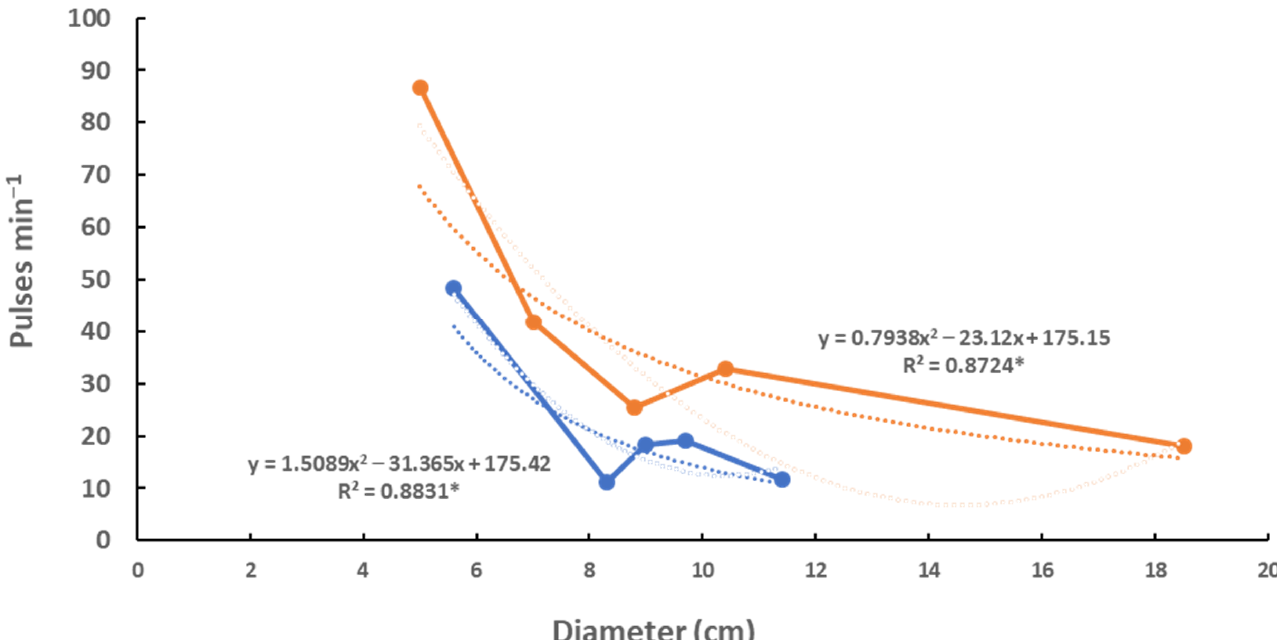
Figure 8. Pulse rates of C. xamachana (red) and C. frondosa (blue). Regressions with * are significant ( p <